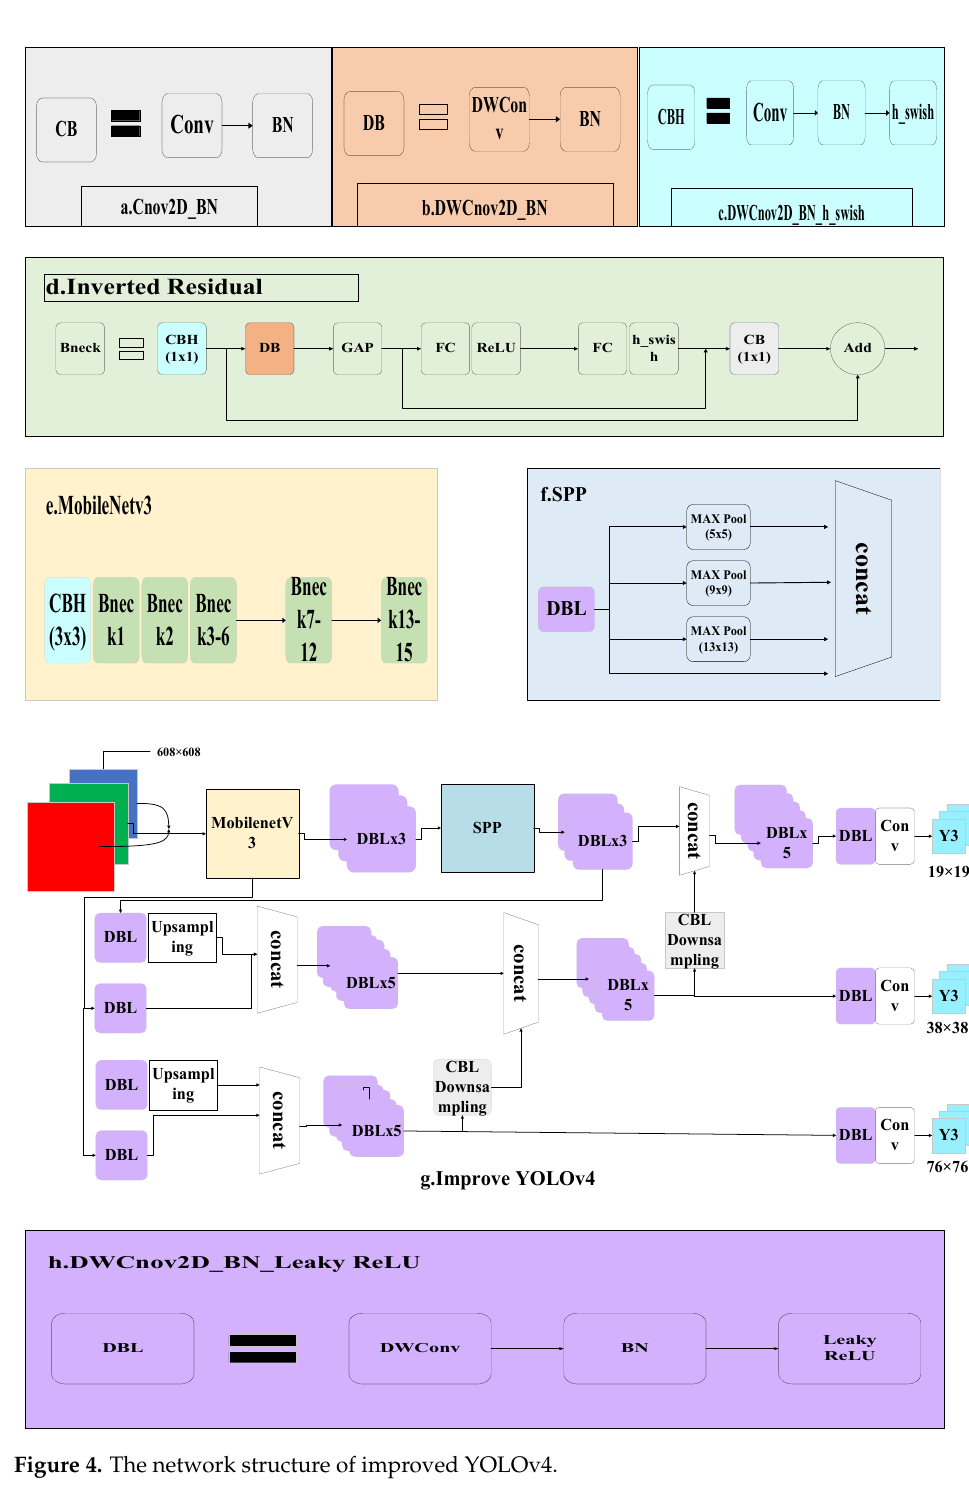
Figure 4. The network structure of improved YOLOv4.